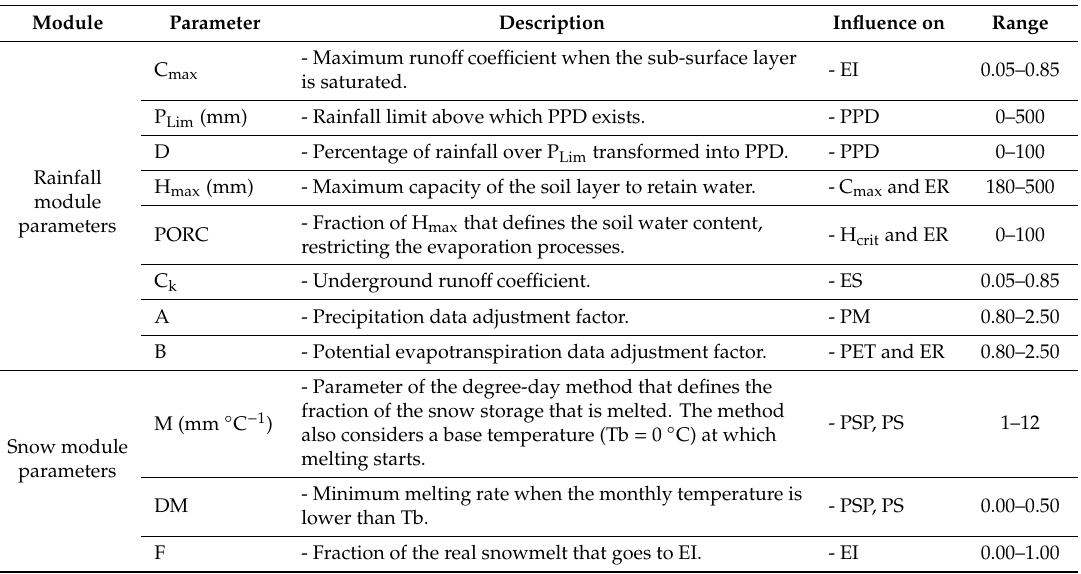
Table 1. Description of the model parameters, adjustment factors and ranges for the rainfall- and snowmelt-runo ff